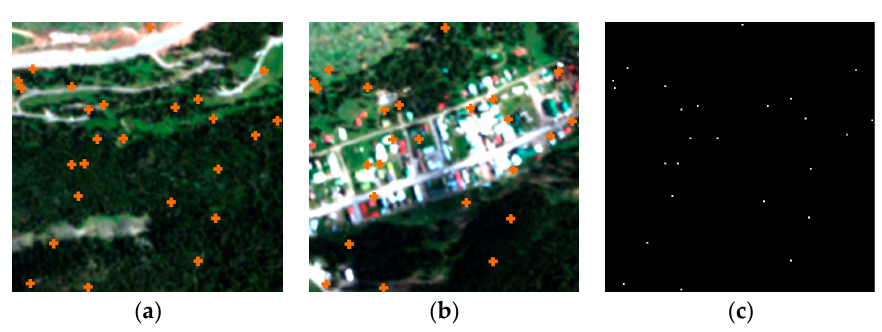
Figure 3. HyMap data set.